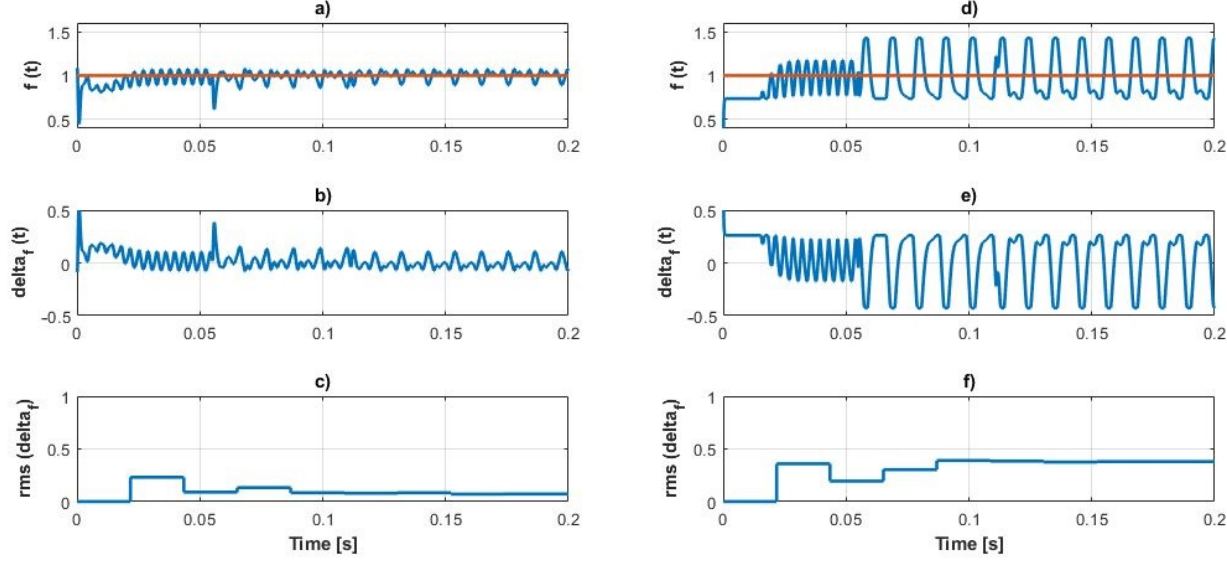
Figure 12. Frequency estimation in presence of harmonics for RFE-FLL ( a – c ) and SRF-FLL ( d – f ) where: ( a , d ) frequency estimated value (orange—reference, blue—tested algorithm), ( b , e ) frequency error between compared algorithms, and ( c , f ) RMS value-form frequency error.